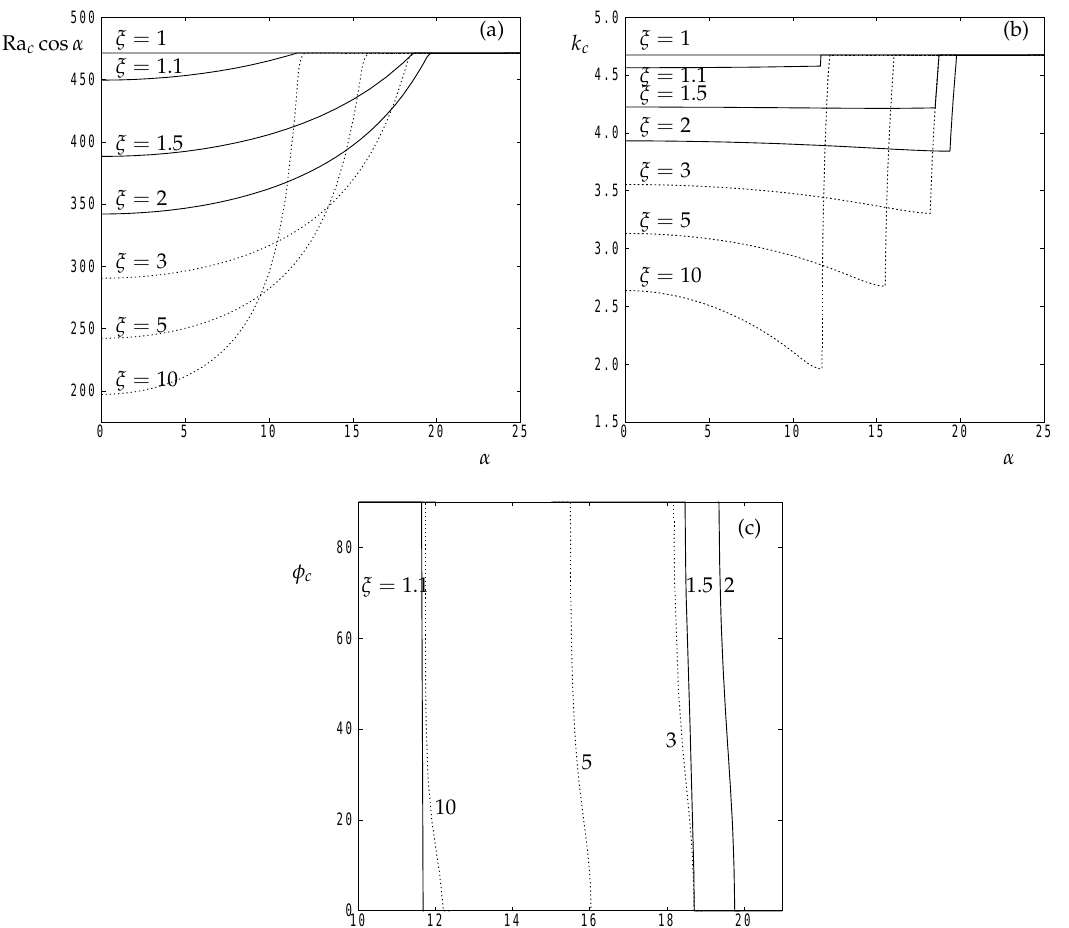
Figure 10. As functions of the inclination, α : ( a ) the critical value of Ra cos α which has been minimised over both wavenuber and roll orientation; ( b ) the corresponding wavenumber; ( c ) the corresponding roll orientation in degrees. For ξ = 1, 1.1, 1.5 and 2 (continuous lines) and for ξ = 3, 5 and 10 (dotted lines).